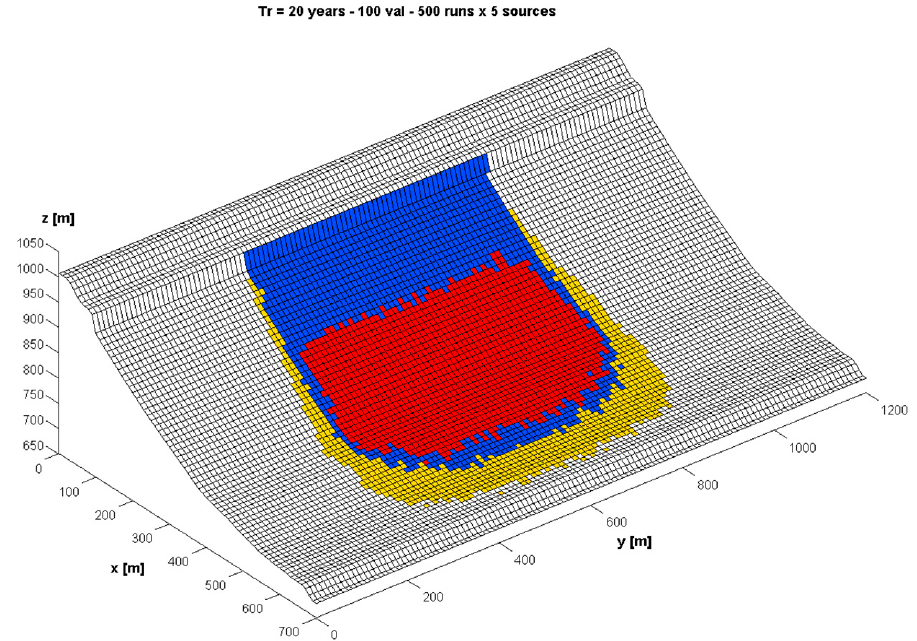
Figure 6. Hazard zoning for a diffuse linear source problem, performed according to the Swiss Guidelines, assuming a failure frequency λ f, 2 D = 0.0025 (years − 1 · m − 2 ), i.e., λ f,cell = 0.25 years − 1